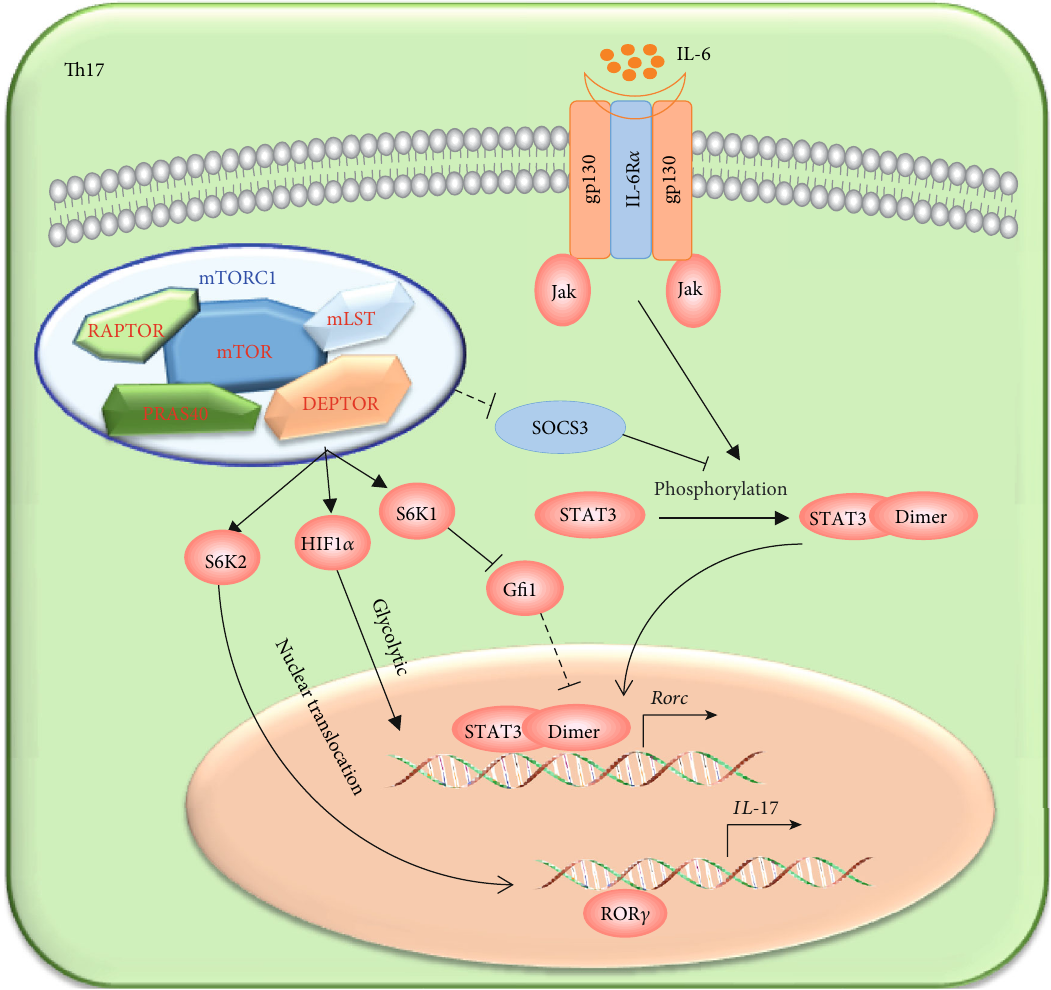
Figure 5: The regulation of mTOR on Th17 cell di ff erentiation. Th17 cell di ff erentiation is regulated mainly by mTORC1. mTORC1 positively regulates the Rorc expression and Th17 cell di ff erentiation through the following pathways: (1) inhibiting the expression of SOCS3, which could inhibit the activation of STAT4; (2) regulating the expression of Rorc through the SGK1-G fi 1 signaling pathway; (3) promoting the nuclear translocation of ROR γ through S6K2; and (4) activating the HIF1 α -dependent glycolytic